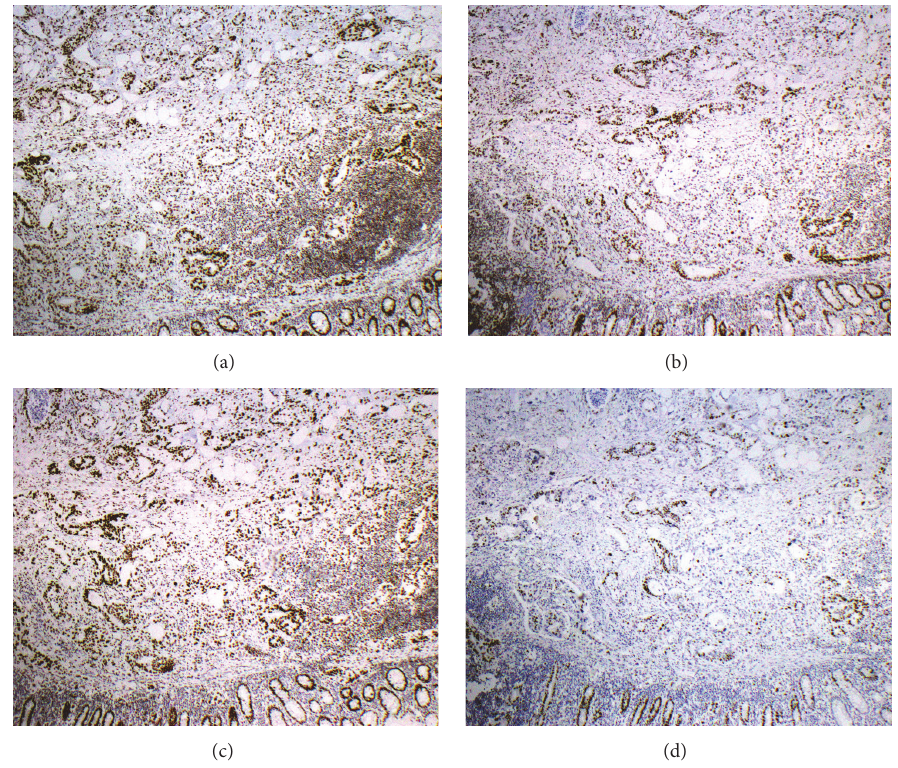
Figure 2: Microsatellite Instability Profile demonstrating no loss of protein expression by immunohistochemical staining. Normal internal control of benign colonic mucosa is located at bottom of each picture. (40x) (a) MLH1, (b) PMS2, (c) MSH2, and (d) MSH6.